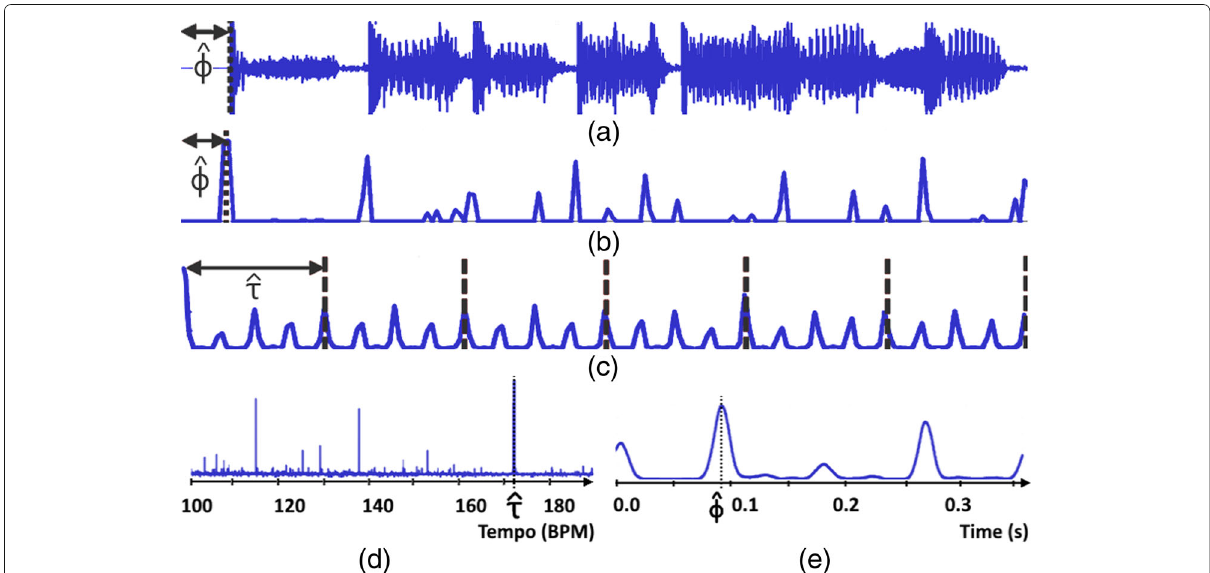
Fig. 3 Illustration of the beat tracking algorithm. a Audio waveform extract. b Half-wave rectified onset detection function (cid:5) HWR ( m ) . c Autocorrelation function A (cid:5) ( l ) of the ODF. d Tempo detection curve B (τ) . e Phase detection curve (cid:6)(φ) . Our algorithm’s estimate of the beat period ˆ τ and the beat phase ˆ φ are annotated. This figure was created by applying the algorithm to a piece of audio of 4 m 30 s long. For illustrative purposes, only the first few seconds of the audio waveform, ODF and autocorrelation function are shown. Note that the described algorithm detects the beats between 160 and 190 BPM, and a larger tempo range is shown in d for illustrative purposes